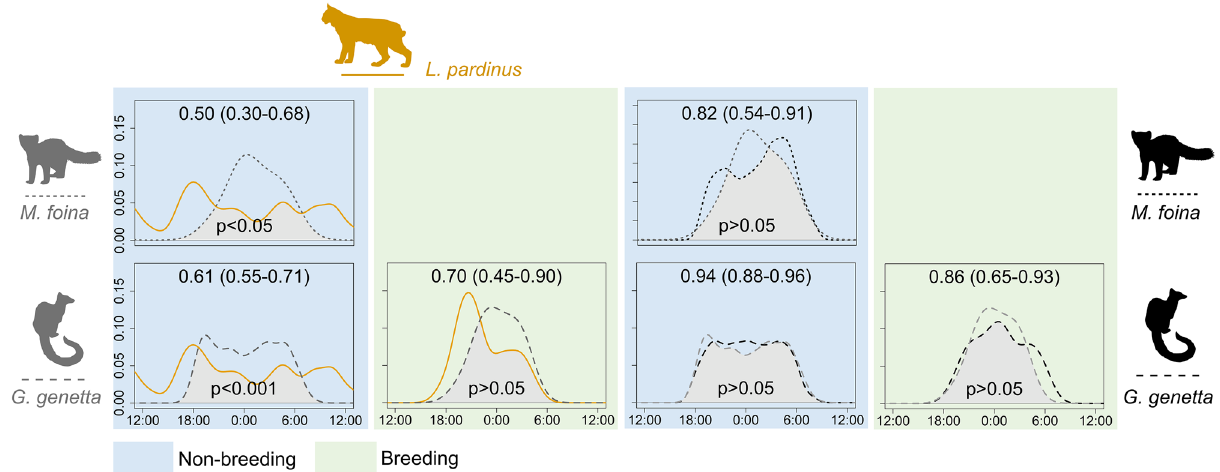
Figure 3. Temporal activity patterns of carnivores in localities with Iberian lynx presence (lynx silhouette) and localities without lynx (no lynx silhouette) outside the breeding season (blue boxes) and inside (green boxes). The Iberian lynx is represented by orange solid line, the stone marten by dotted line and the common genet by dashed line. Mesocarnivores co-existing with lynx are coloured in dark grey and mesocarnivores living outside lynx ranges in black. Empty plots refer to overlap unrealized